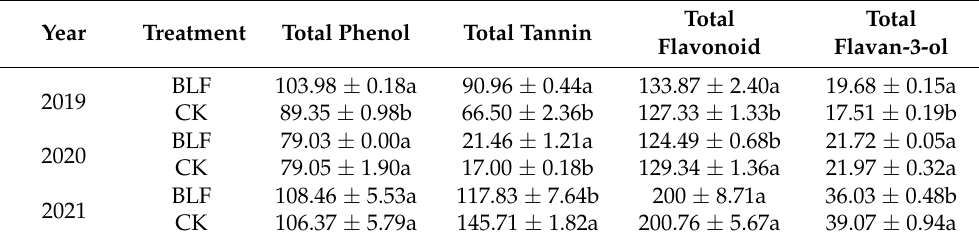
Table 3. Concentrations (mg/g, mean ± standard deviation) of polyphenols in Cabernet sauvignon grape seeds from BLF and CK treatments in 2019, 2020, and